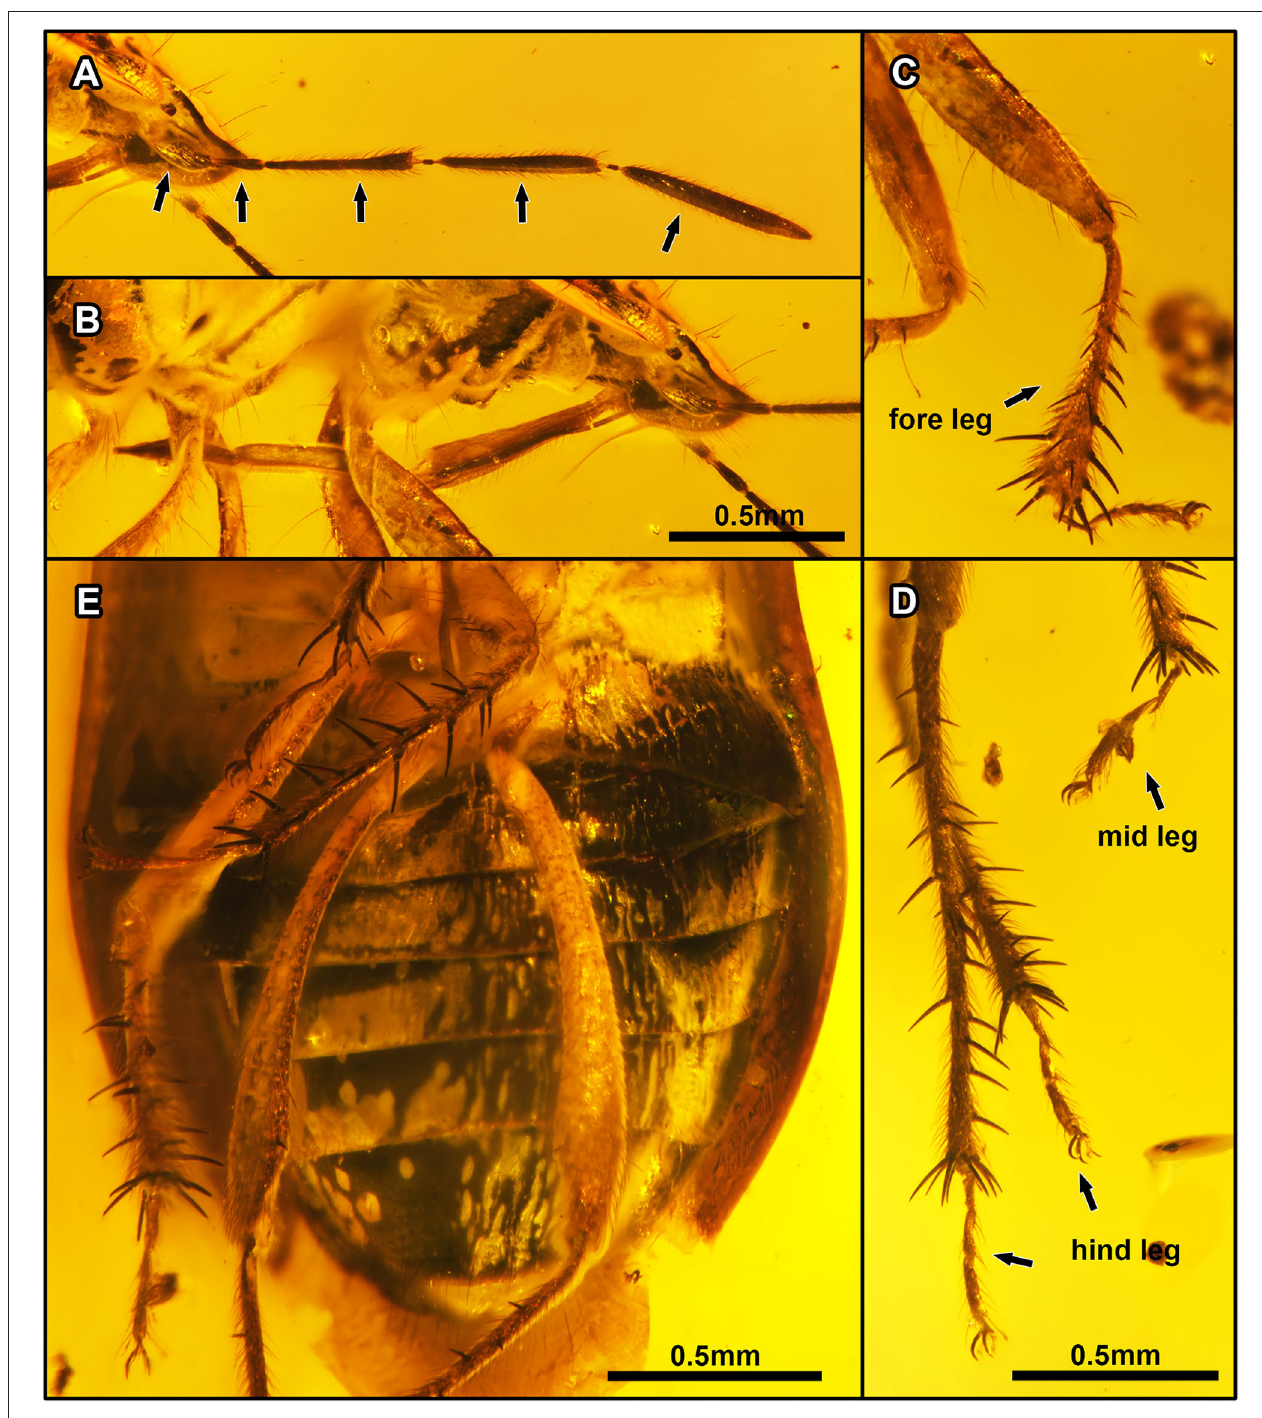
FIGURE 6 | Laevigemma lisorum gen. et sp. nov., in Burmese amber. Related to Figure 2 . Holotype, CNU-HET-MA2019004 (male). (A) Habitus in right lateral view of head, arrows indicate five antennomeres. (B) Rostrum in right lateral view. (C) Right foreleg. (D) Mesotarsi and right metatarsus. (E) Abdomen in ventral view. Scale bars: A = B = 0.5mm; C = D = 0.5mm; E = 0.5mm.